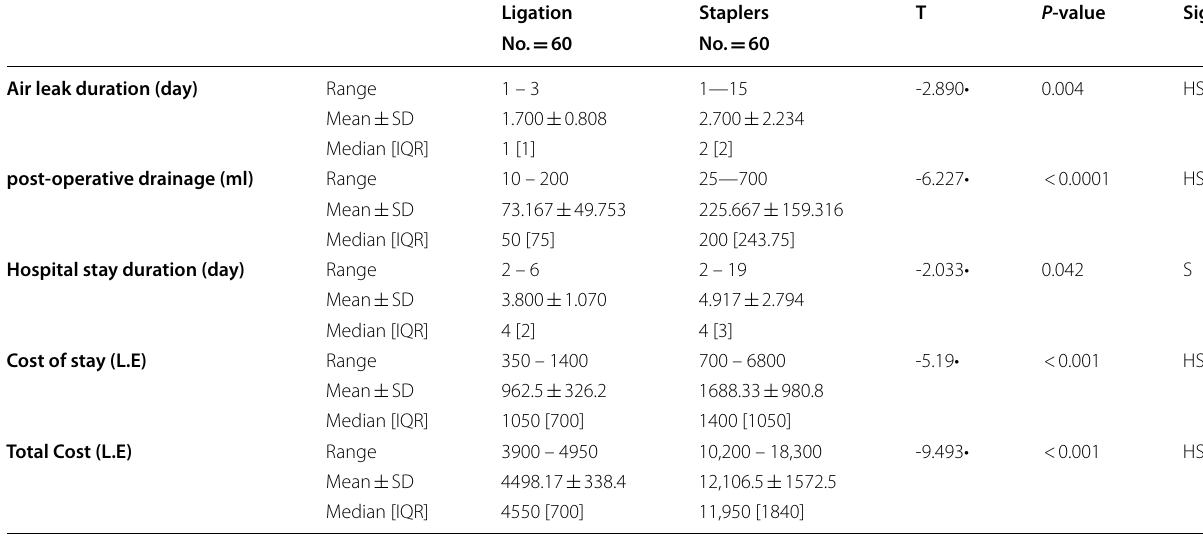
P -value > 0.05: Non-significant, P -value < 0.05: Significant, P -value < 0.01: highly significant